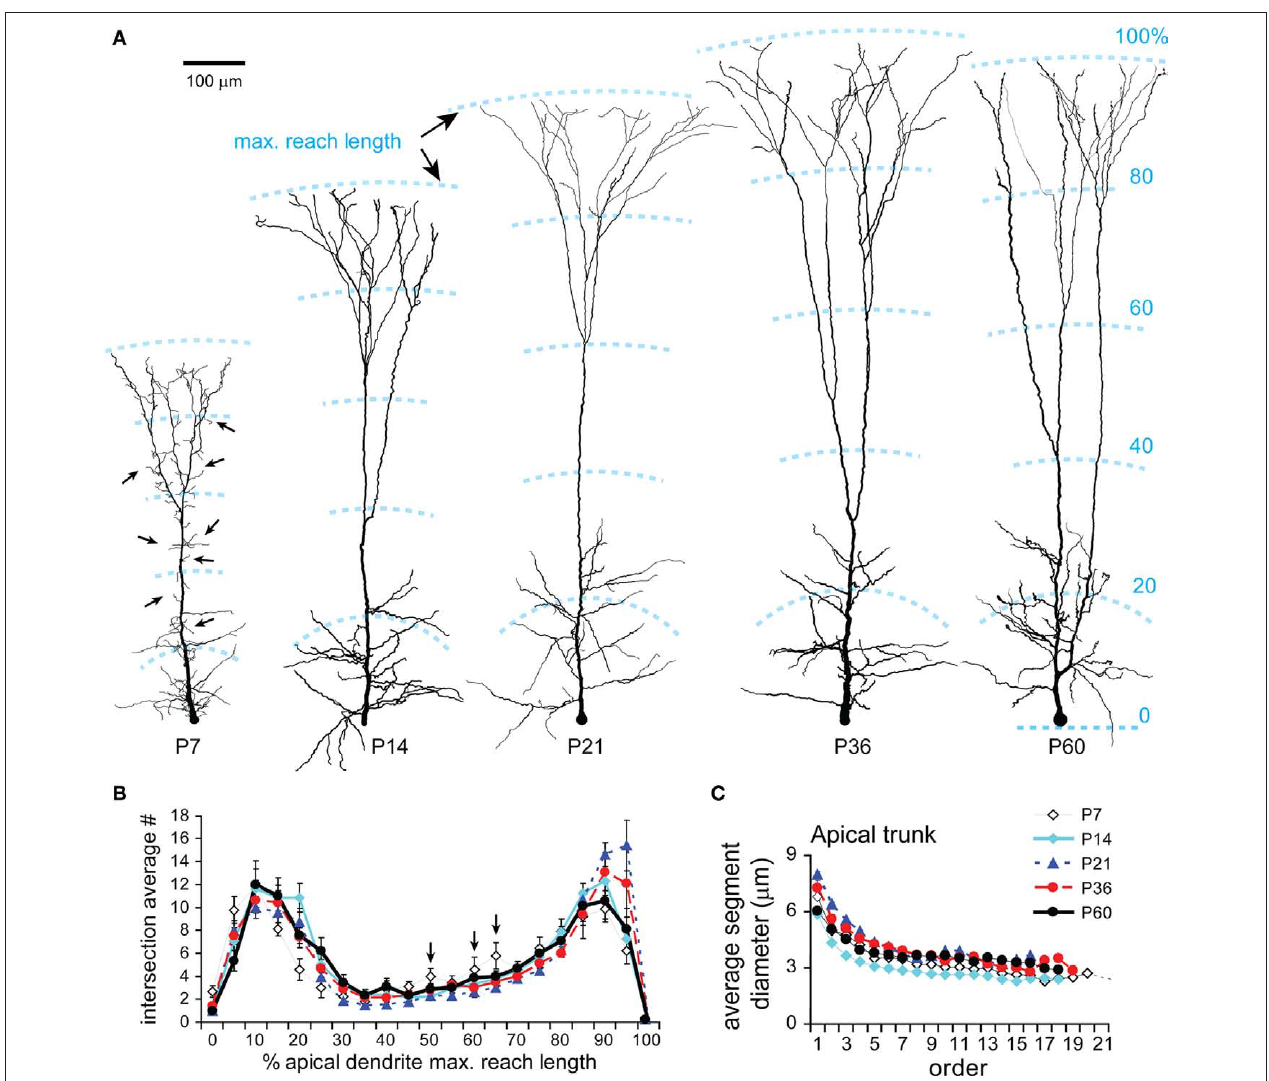
n = 9). The radii of concentric spheres were normalized to the maximal reach length of each apical dendrite. Note the similar general profiles at all ages. At P7, the higher number of intersections in the middle of apical dendrite (black arrows), is most likely due to filopodia-like branches. (C) The average diameter of apical trunk at different branch orders was constant during the studied